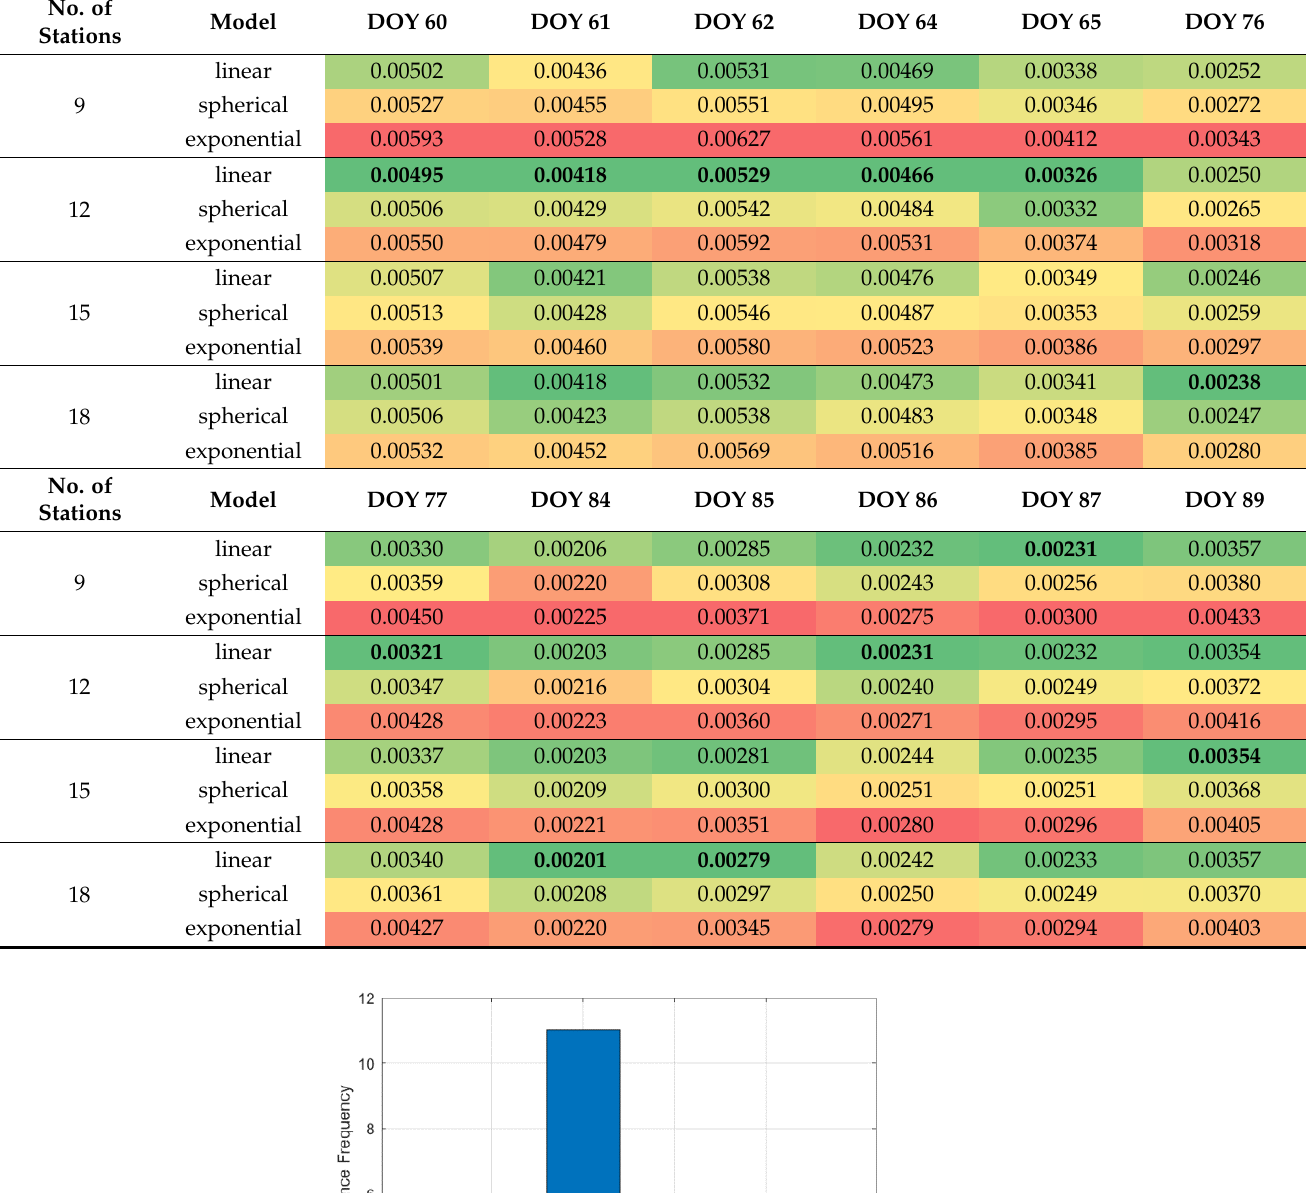
Table 2. Standard deviation values of the mean normalized error throughout 12 days of March 2015. Values in bold and in green indicate the least value on that day. The worst-performing sets are in red.